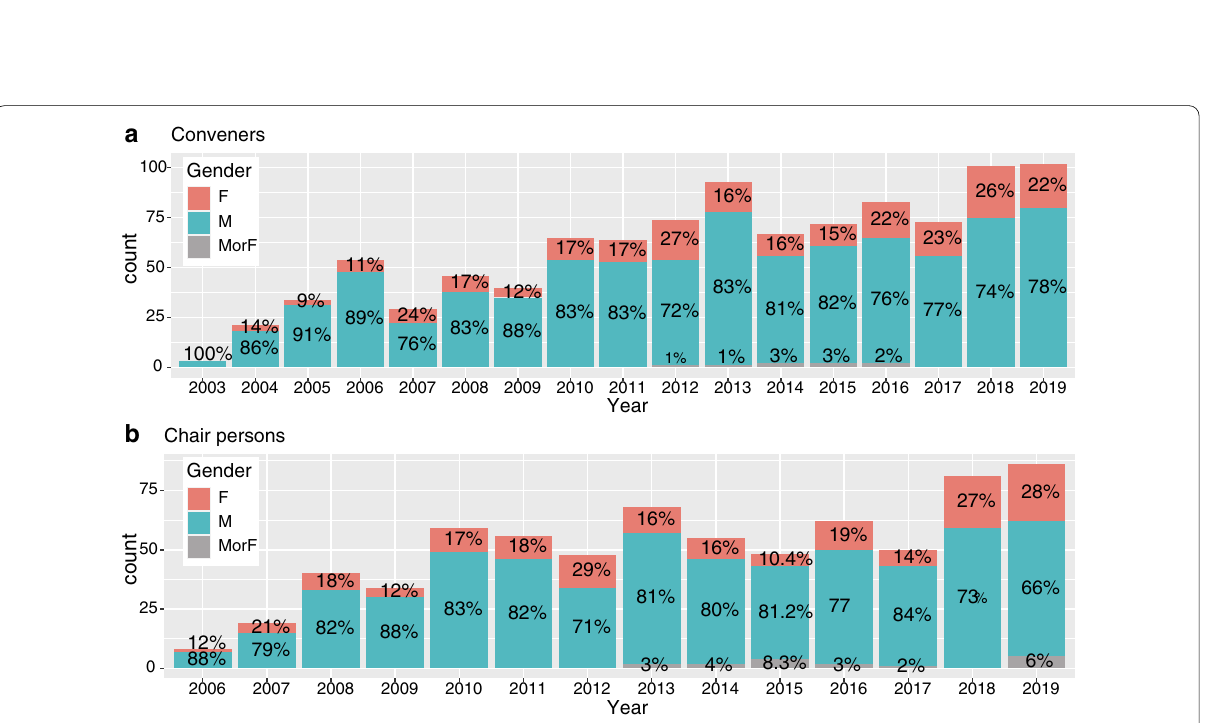
Fig. 6 Number of session conveners ( a ) and chair persons ( b ) per year classified by gender. Percentages are reported on the graph. Conveners and chair persons for which we were unable to retrieve the gender information are classified as male or female